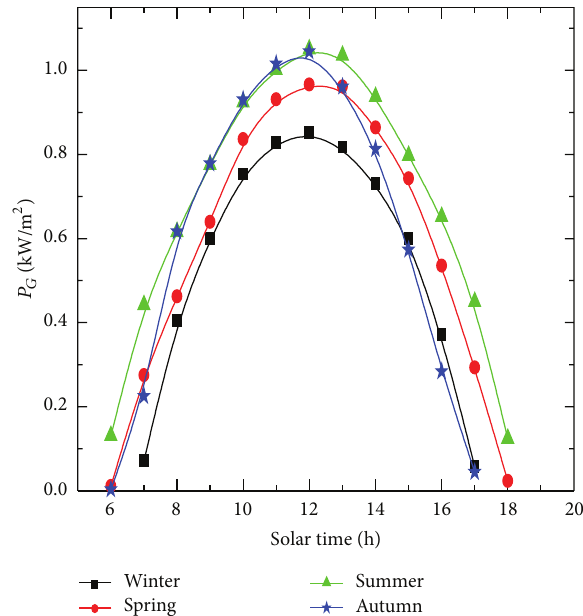
Figure 11: The hourly distribution of the global solar energy radiation in Riyadh city over the year